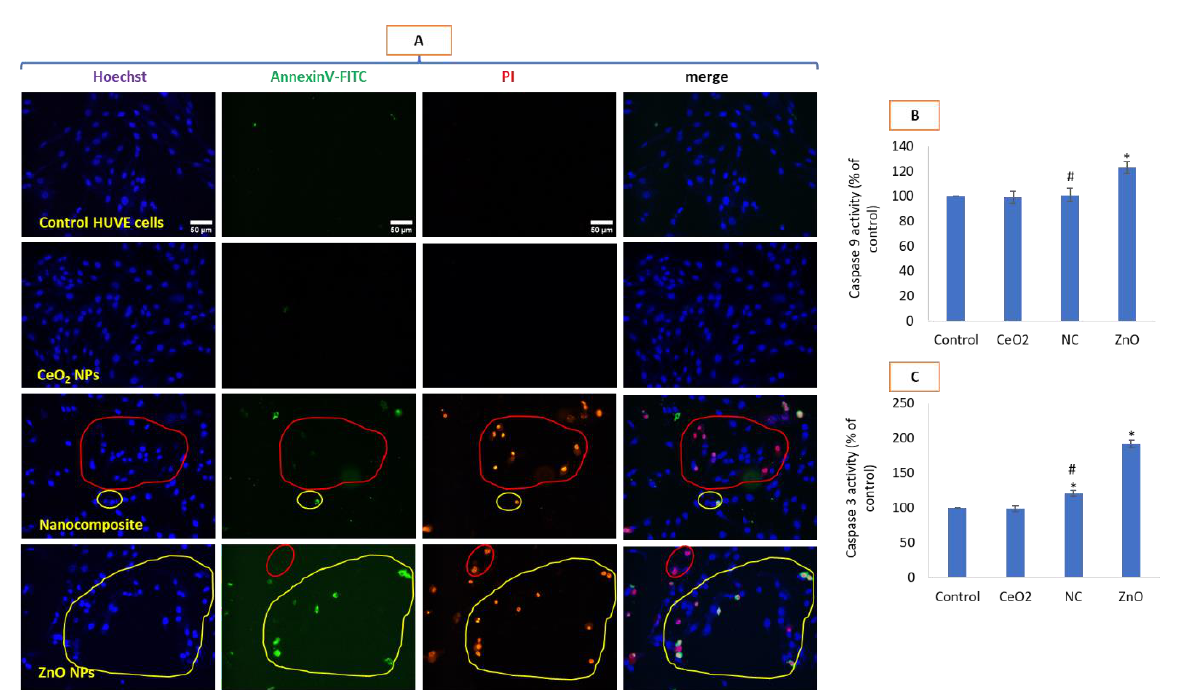
Figure 7. HUVEC cells treated with mentioned NPs for 24 h and potential induction of apoptosis/necrosis was determined by triple staining ( A ), caspase 9 activity ( B ) and caspase 3 activity ( C ). Cells were stained with Hoechst 33442 (blue color) that stains the nucleus of live or dead cells, PI (red color) that stains the nucleus of only dead or dying cells and annexin-V (green color) that preferentially stains apoptotic cells. Dying or dead cells that are stained with PI but lack annexinV-FITC fluorescence clearly undergo a mode of cell death that is not apoptosis. Merge refers to the images obtained after color merging of triple images of Hoechst, annexinV-FITC and PI, respectively, in ImageJ. Scale bar represents 50 µm and is only provided in control images. Each image was captured by a 20× objective under uniform conditions of illumination intensity, time and other variables. Each experiment was performed in triplicates ( n = 3). *statistically significant difference from the control ( p < 0.05). # statistically significant difference in between treatments of CeO 2 -Zn nanocomposite and ZnO NP ( p < 0.05).